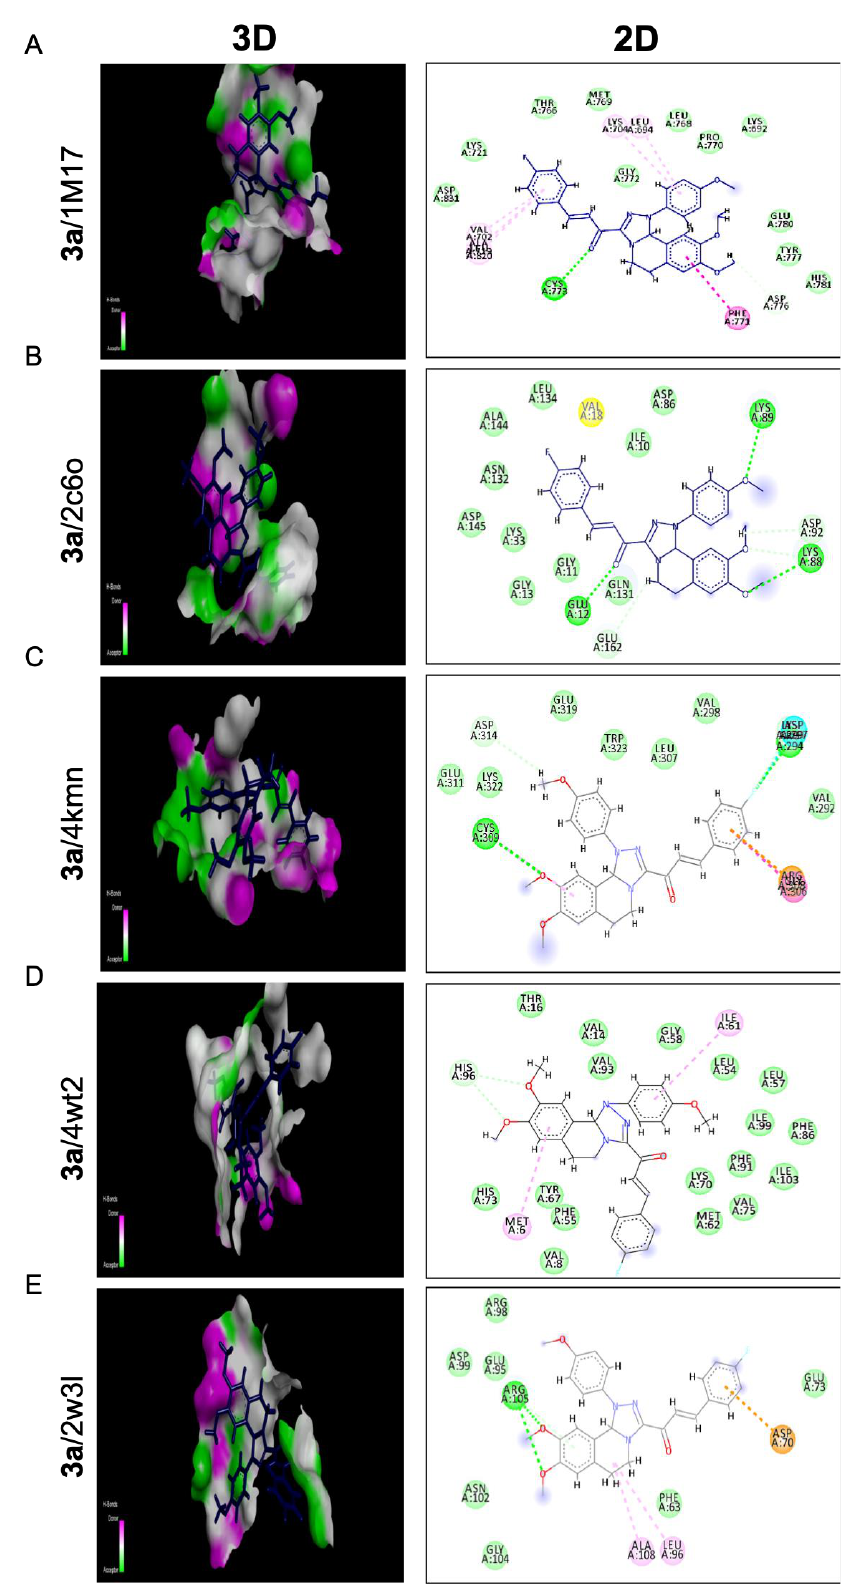
Figure 6. Molecular docking analysis of chalcone compound 3a. Representation of 3D and 2D modeling into the active site of ( A ) epidermal growth factor receptor tyrosine kinase domain (1m17), ( B ) cyclin-dependent kinase 2 domain (2c6o), ( C ) cellular inhibitor of apoptosis protein 1 domain (4kmn), ( D ) mouse double minute 2 domain (4wt2), and ( E ) B-cell lymphoma 2 domain